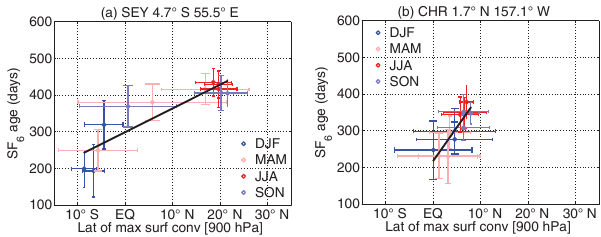
Figure 7. As in Fig. 6a and c but for the relationship between ob- served SF 6 age and the latitude of the ITCZ, for measurements from (a) Seychilles and (b) Christmas Island.